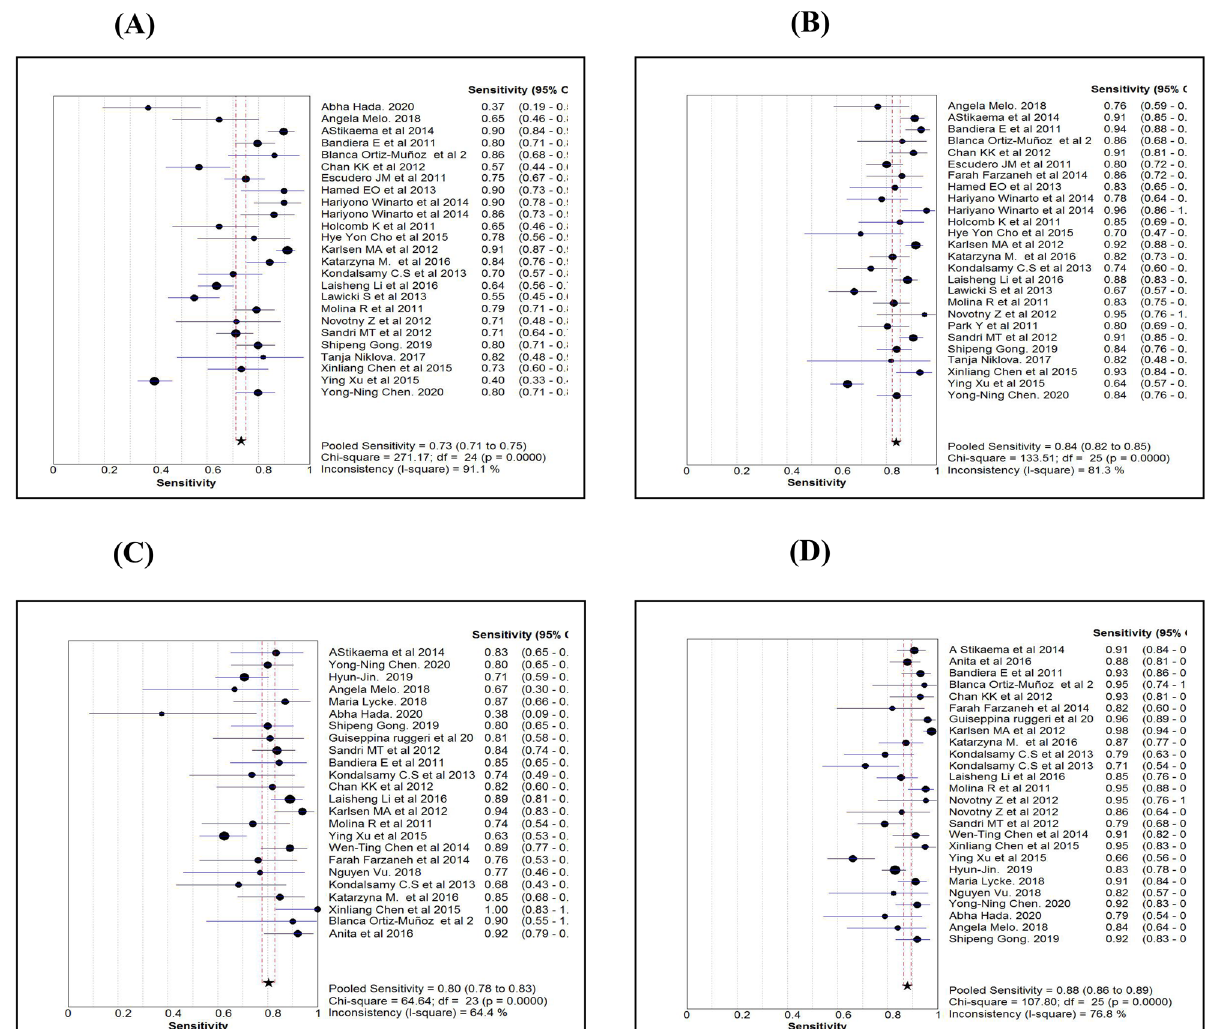
Figure 3. Comparison of Sensitivity estimates of HE4 ( A ), CA125 ( B ), ROMA for pre-menopause ( C ) and ROMA for post-menopause ( D